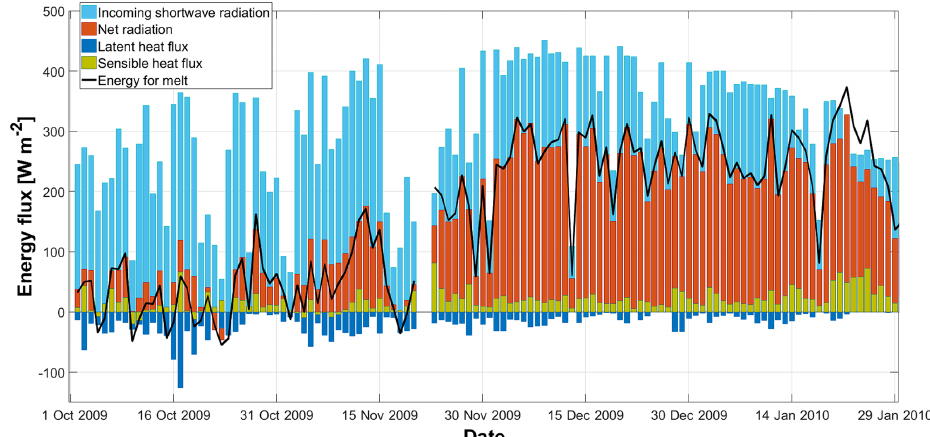
Figure 6. Daily mean net radiation, incoming shortwave radiation, turbulent latent and sensible heat fluxes and the calculated energy available for melt at AWS1 (2650ma.s.l.). On 21 and 22 November there are no data due to maintenance of AWS1.